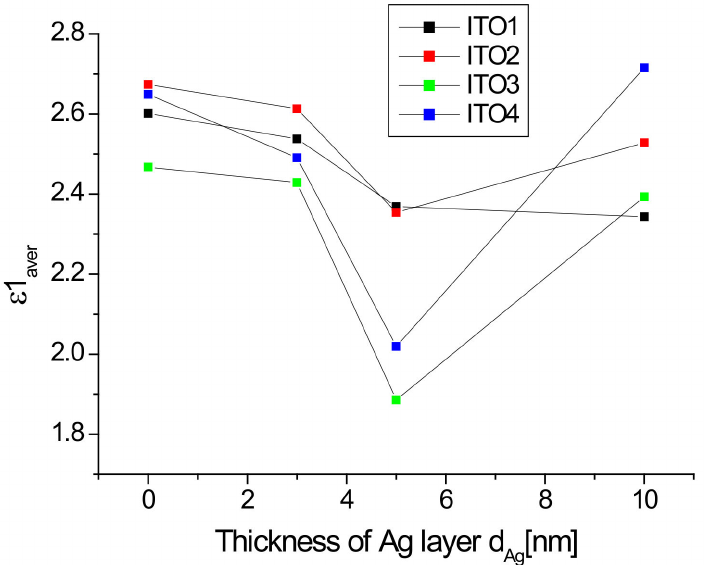
Figure 9. Real part of the dielectric function for ITO1/glass and Ag/ITO1/glass